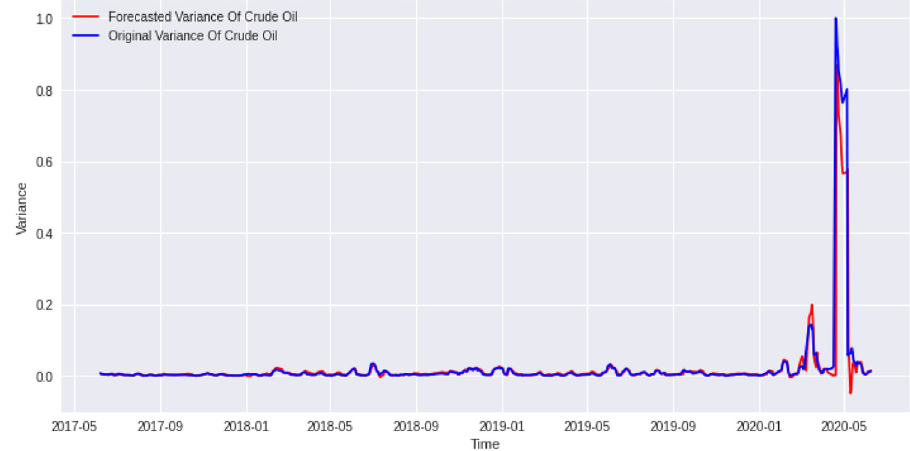
Fig 16. Forecasted values vs actual values of daily crude oil price variance from May 2017 to June 2020. The lookback period is 8 days. The number of epoch is 68. The activation function is ‘tanh’. and the gradient descent optimizer is “ Nadam ”. It gives a R-squared of 80.74%. We can see that our model rightly predict the crude oil April 20, 2020, high volatility phase.